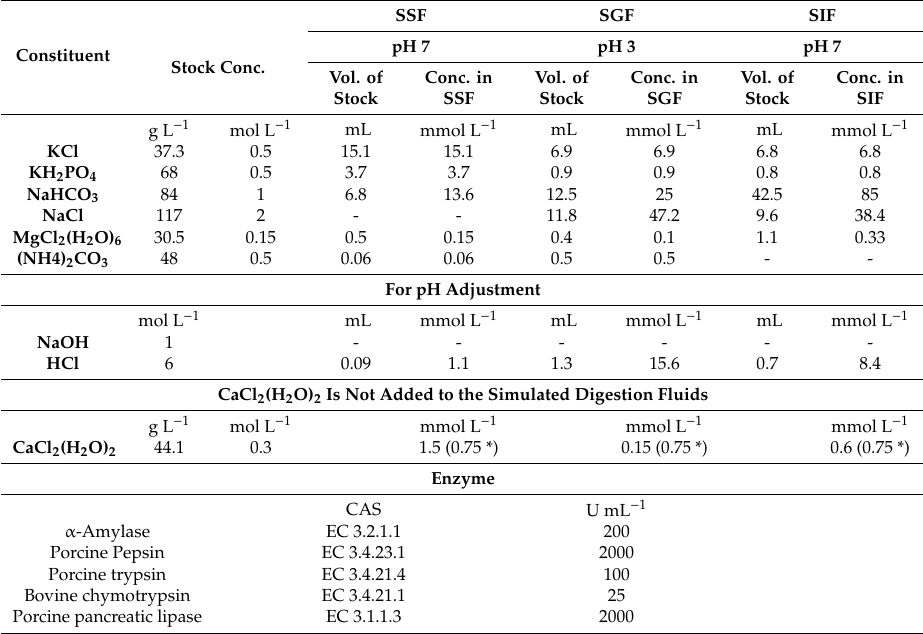
Table 3. Preparation of stock solutions of simulated digestion